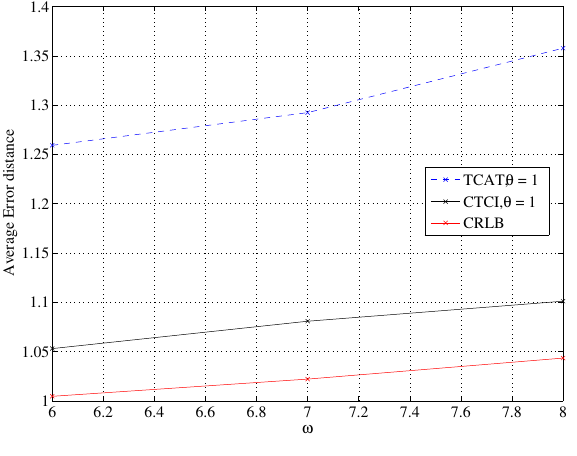
Figure 23. Impact of noise on the average error distance.